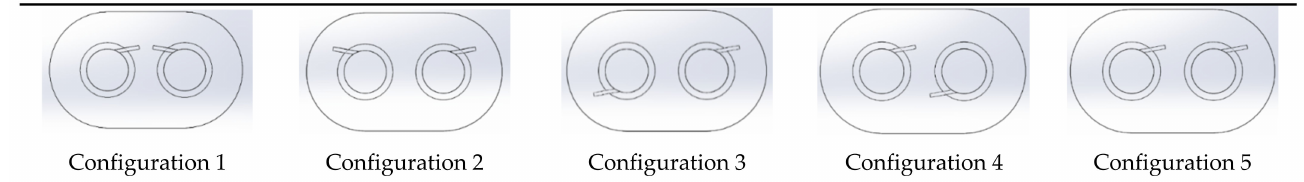
Figure 6. Quad-vortex grippers.